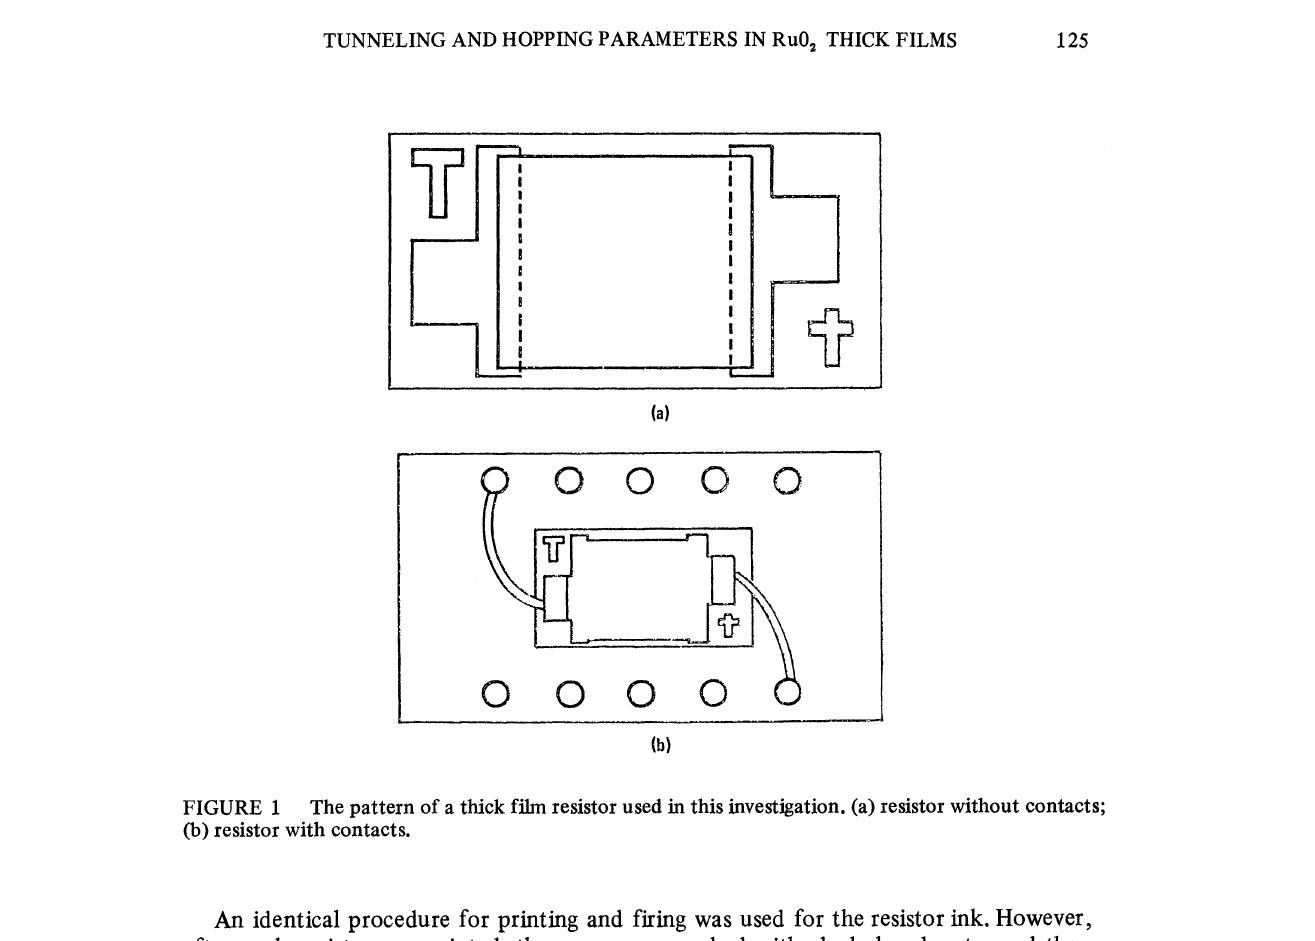
FIGURE 1 The pattern of a thick film resistor used in this investigation. (a) resistor without contacts; (b) resistor with